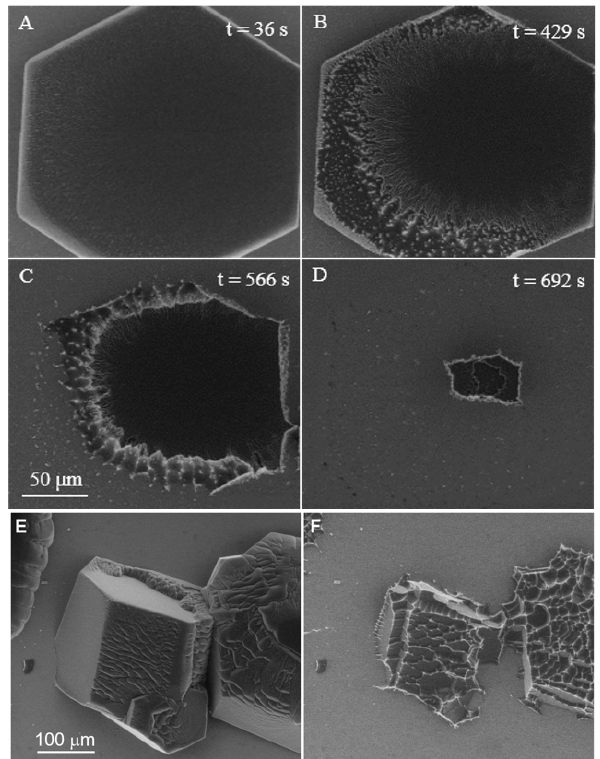
Figure 5. Sublimation sequence of hexagonal crystals. (a, d) The basal plane of an isolated crystal. ESEM conditions: (a) P = 180Pa, T = − 15 . 2 ◦ C, P sat = 162 . 4Pa, h = 1 . 11; (b) P = 139Pa, T = − 18 . 2 ◦ C, P sat = 122 . 7Pa, h = 1 . 13; (c) P = 123Pa, T = − 19 . 1 ◦ C, P sat = 112 . 6Pa, h = 1 . 09; and (d) P = 97Pa, T = − 20 . 1 ◦ C, P sat = 102 . 4Pa, h = 0 . 95. All images have the same scale (see c ). The time elapsed since the onset of sublimation is given in each figure. (e) Merged crystals, − 18.3 ◦ C, P = 126 . 8Pa, P sat = 121 . 5Pa, h = 1 . 04. (f) The same area during the last stage before complete sublimation (6min later). The bright grey back- ground is the pure silicon wafer surface; all other features are ice crystals. Some facets are decorated with bright lines (strings of bright dots). ESEM imaging conditions: P = 130 . 6Pa, T = − 17 . 1 ◦ C, P sat = 136 . 1Pa, and h = 0 .